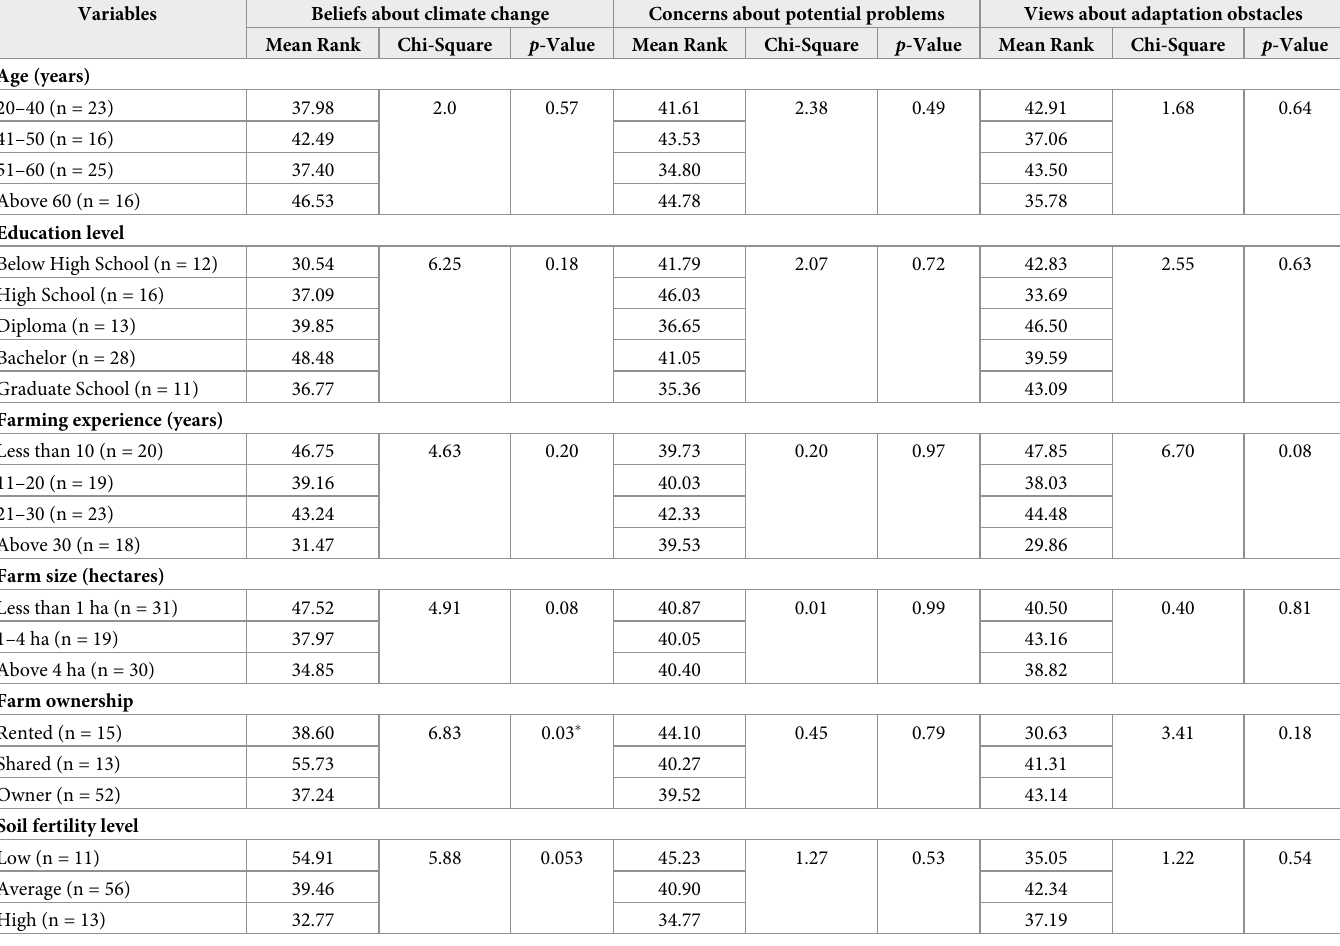
Table 7. Kruskal-Wallis test for differences in farmers’ beliefs, concerns, and views regarding adaptation obstacles.